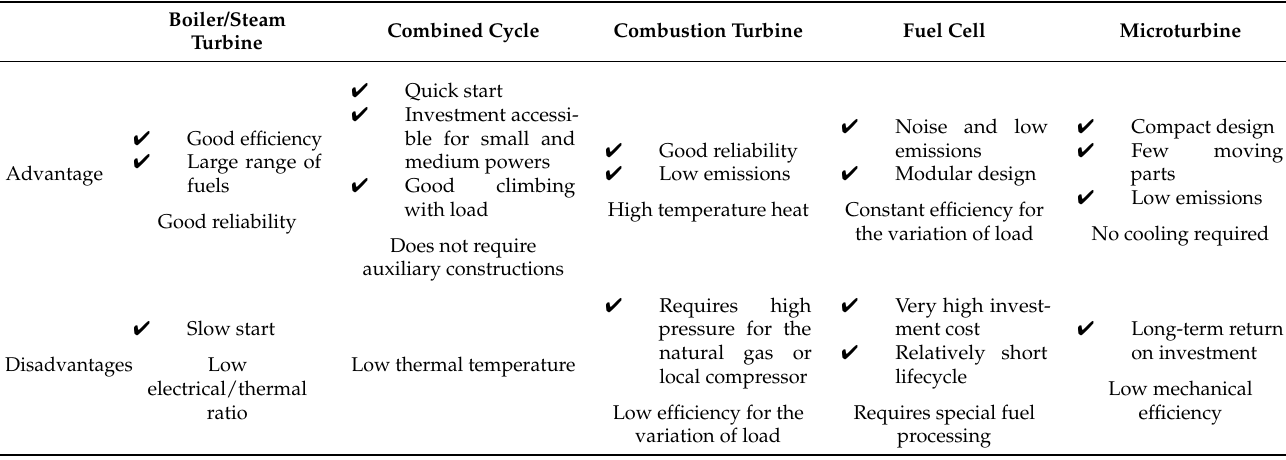
Table 6. Advantages and disadvantages of cogeneration energy production